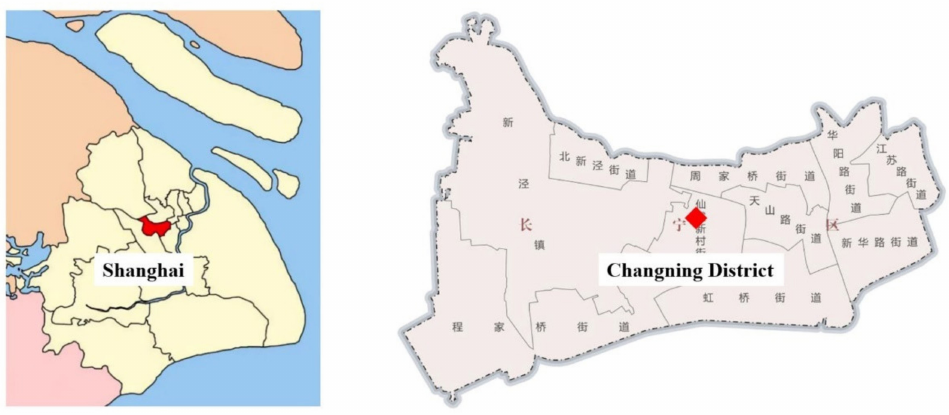
Figure 3. The location of the project.